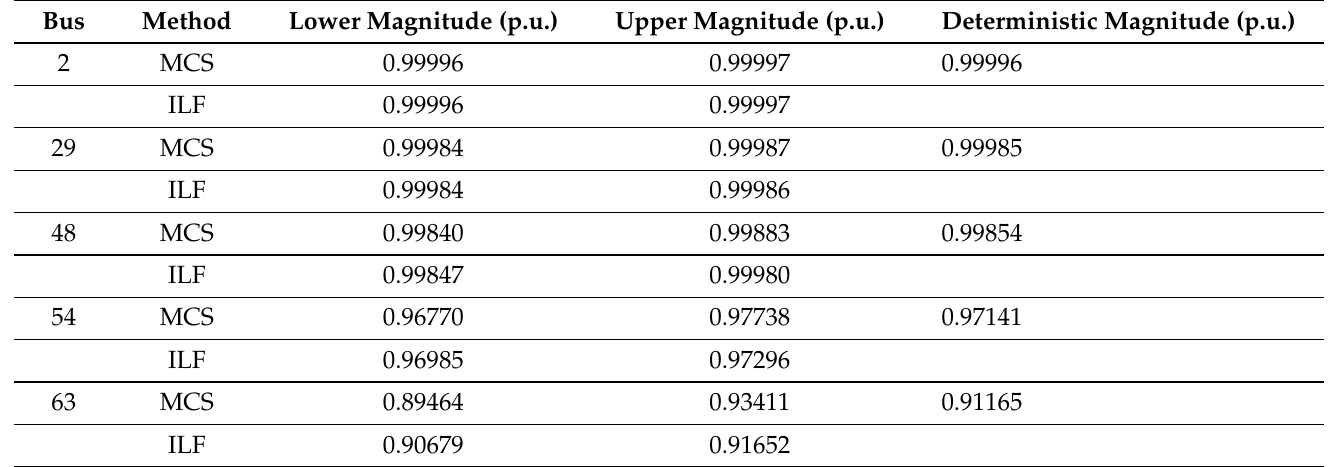
Table 4. Voltage Magnitude—IEEE 69-bus test